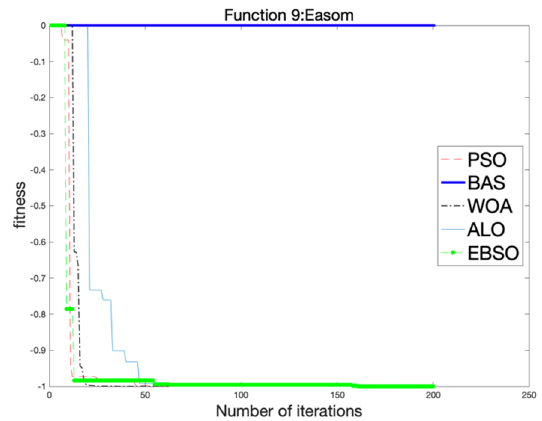
Figure 14. Iterative convergence graph.